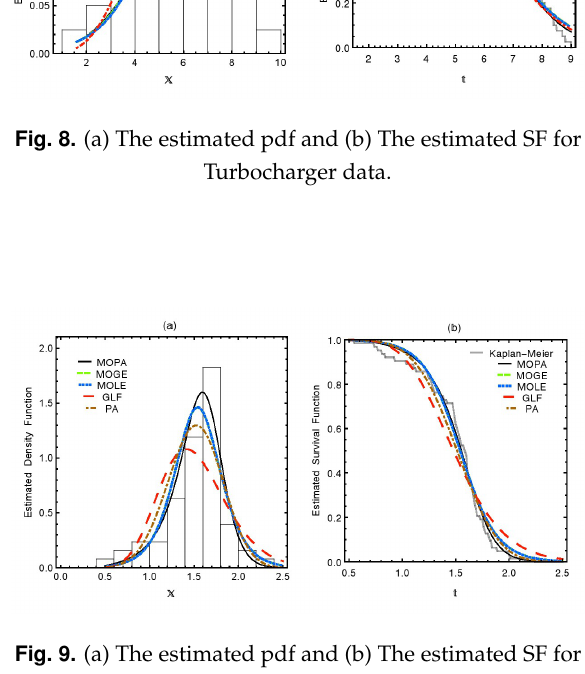
Fig. 9. (a) The estimated pdf and (b) The estimated SF for Glass Fibers data.